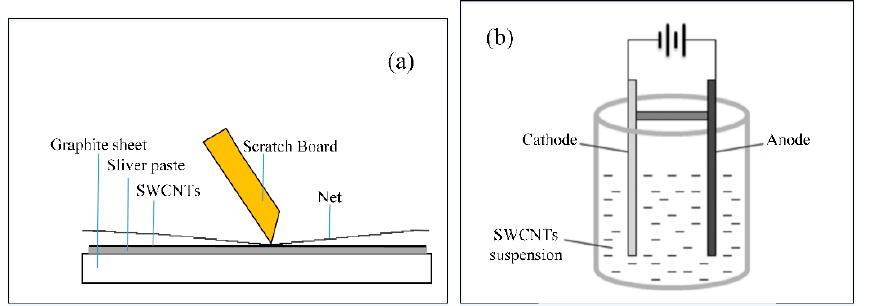
Figure 1. The schematic diagram of the preparation of SWCNT cold cathodes by ( a ) screen printing, and ( b ) electrophoretic deposition. and ( b ) electrophoretic